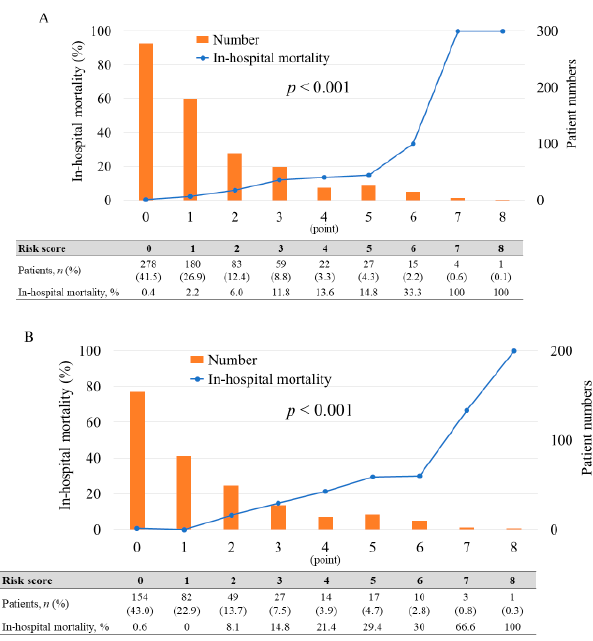
Figure 2. Distribution of risk scores and risk of in-hospital mortality ( A ) derivation cohort and ( B ) validation cohort.